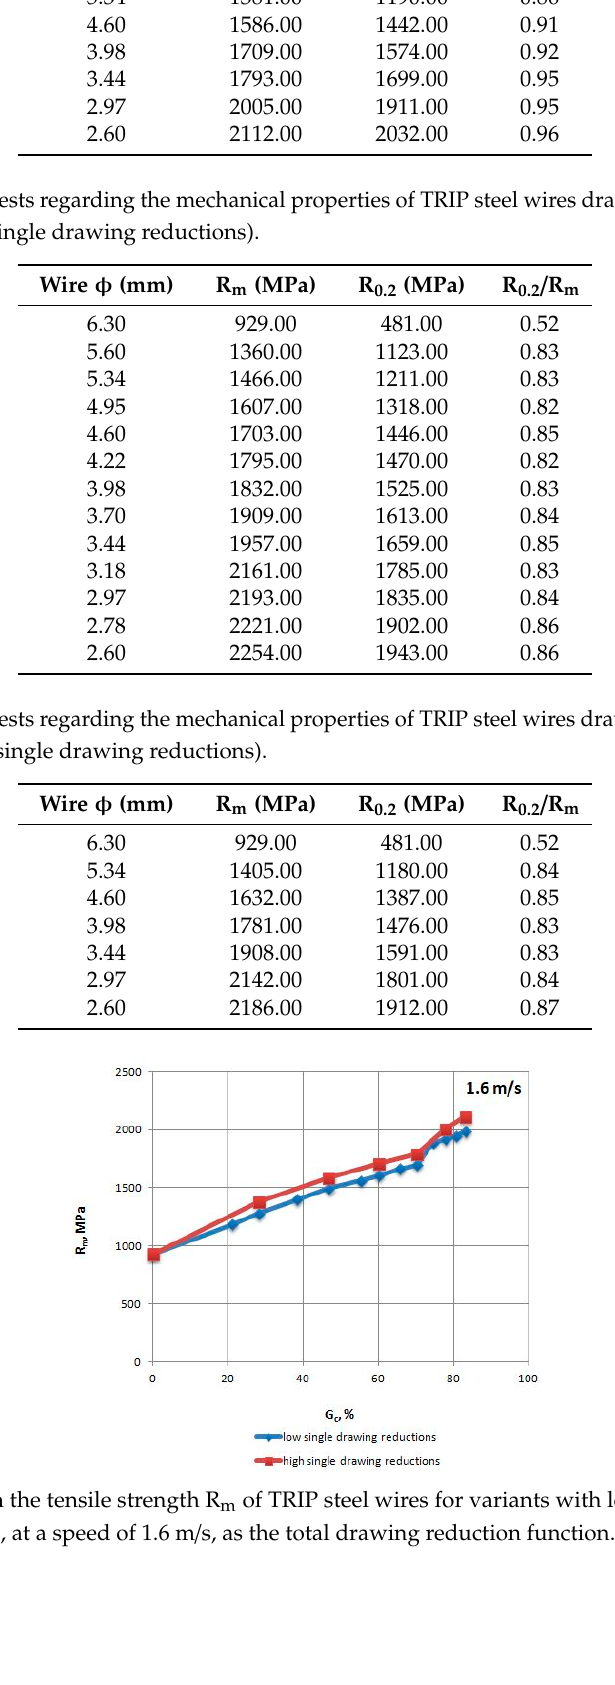
Figure 3. Change of the proof yield strength R 0.2 of TRIP steel wires for variants with low and high single drawing reductions, at a speed of 1.6 m/s, as the total drawing reduction function. Figure 4. Change of the R 0.2 /R m coefficient of TRIP steel wires for variants with low and high single drawing reductions, at a speed of 1.6 m/s, as the total drawing reduction function.